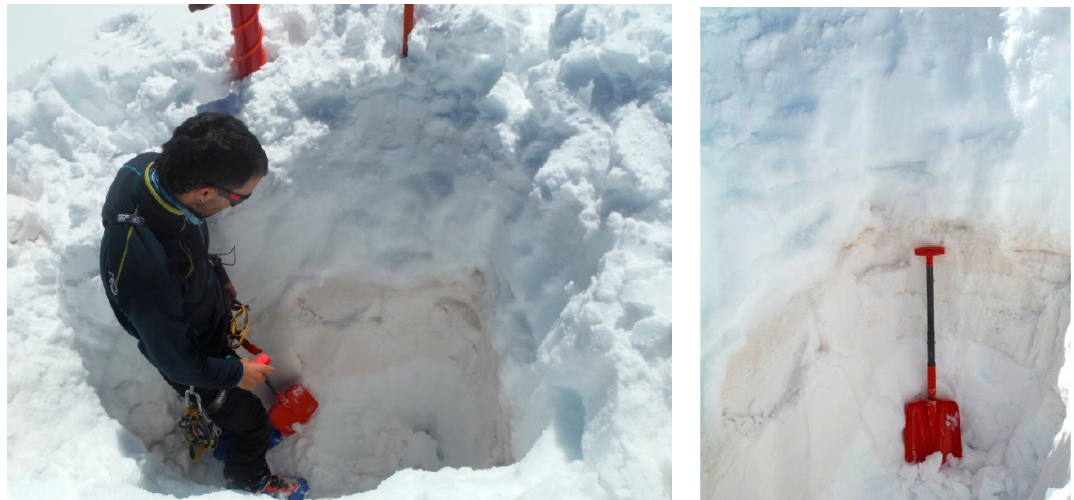
Figure 5. Illustration of the snowpack section after the February 2017 dust event. Sampling site near the Marboré Lake. Photo by M. Bartolomé.